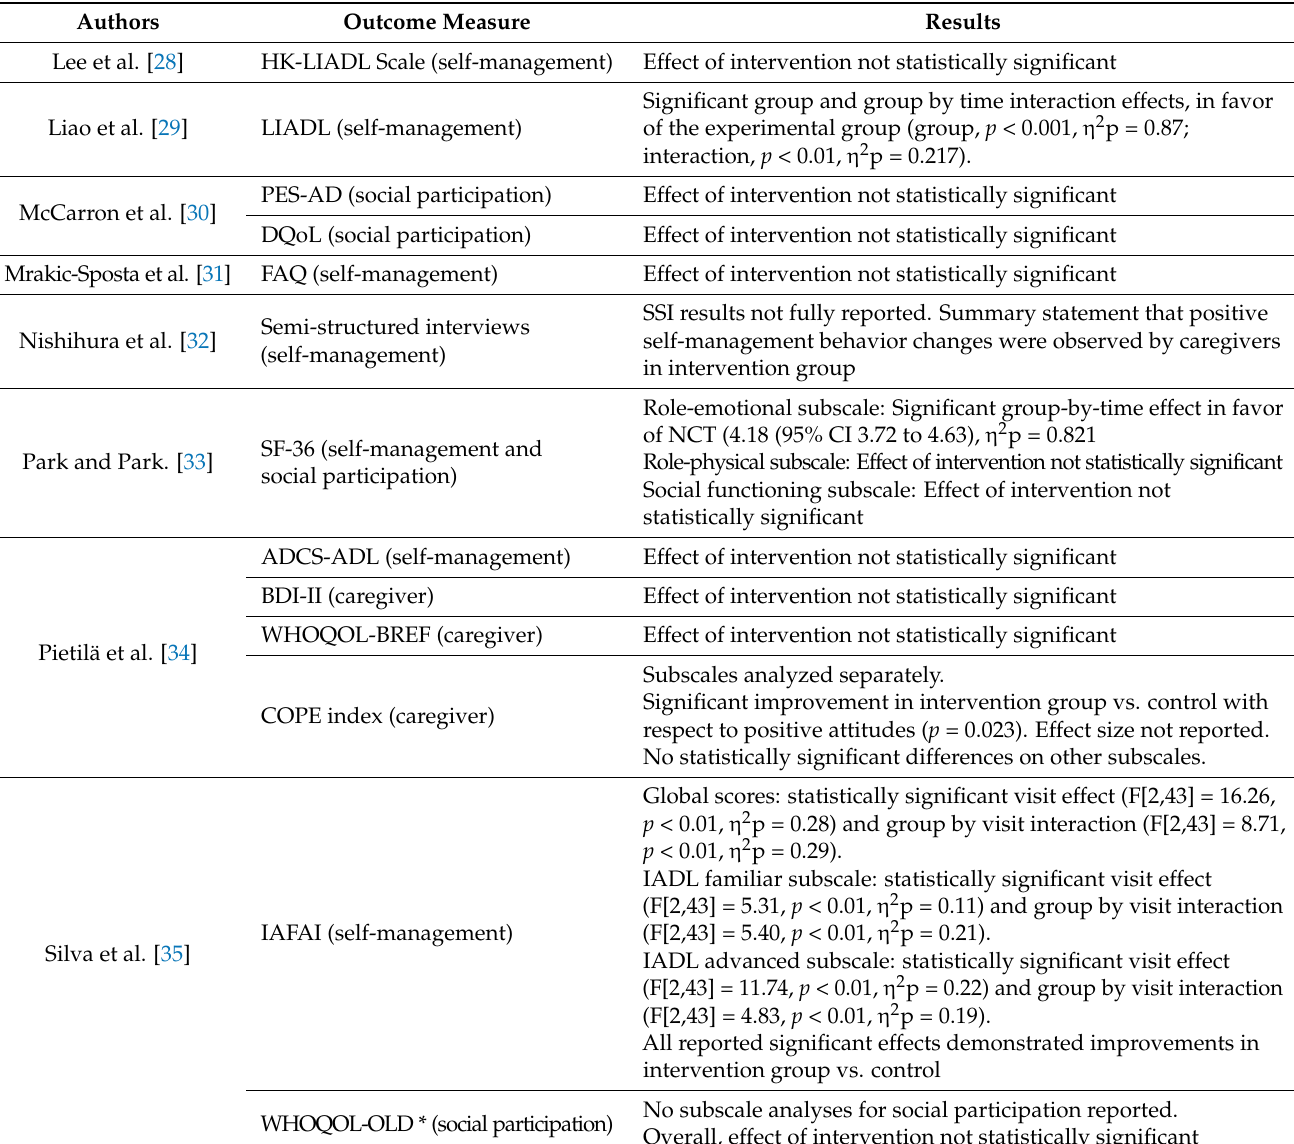
Table 3. Results reported from included